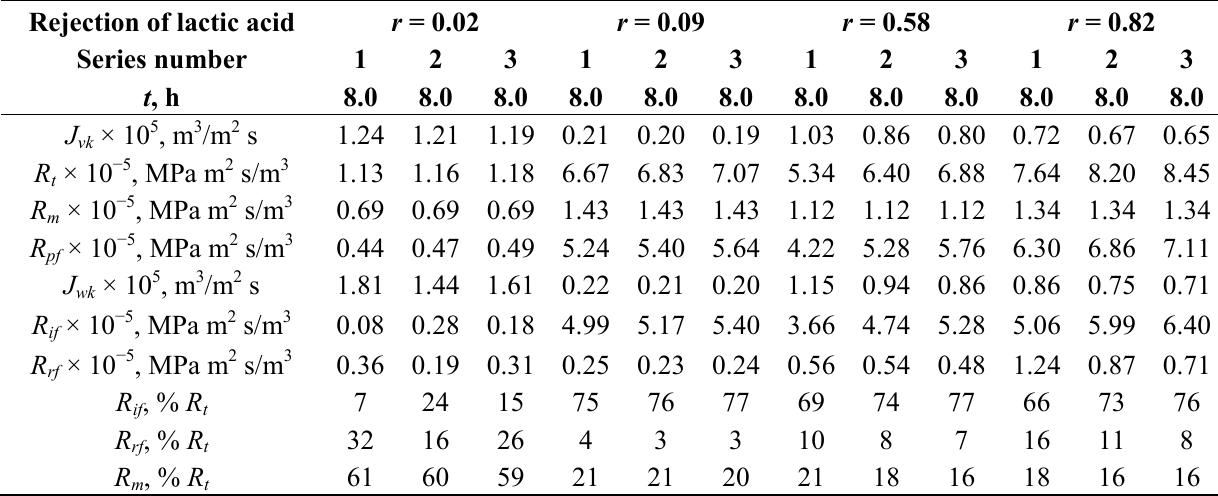
Table 2. Experimental results of permeate fluxes and calculated values of fouling resistances for nanofiltration process of lactic acid solutions with Zr(IV)/PAA dynamically formed membranes.